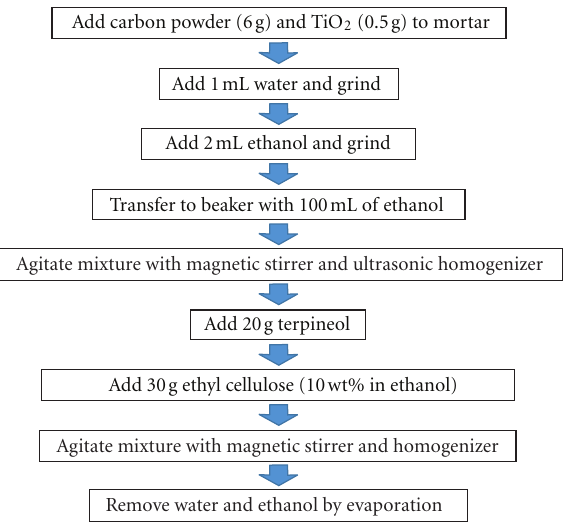
Figure 2: Process for preparing carbon paste for porous carbon electrode in